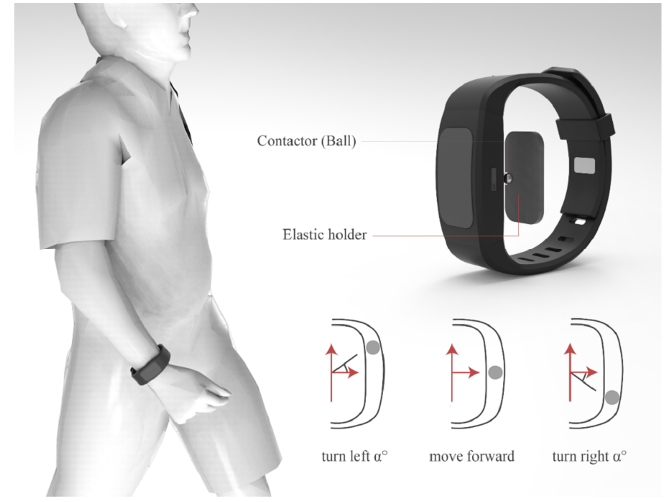
Figure 5. Typical application scenarios of guidance glove.